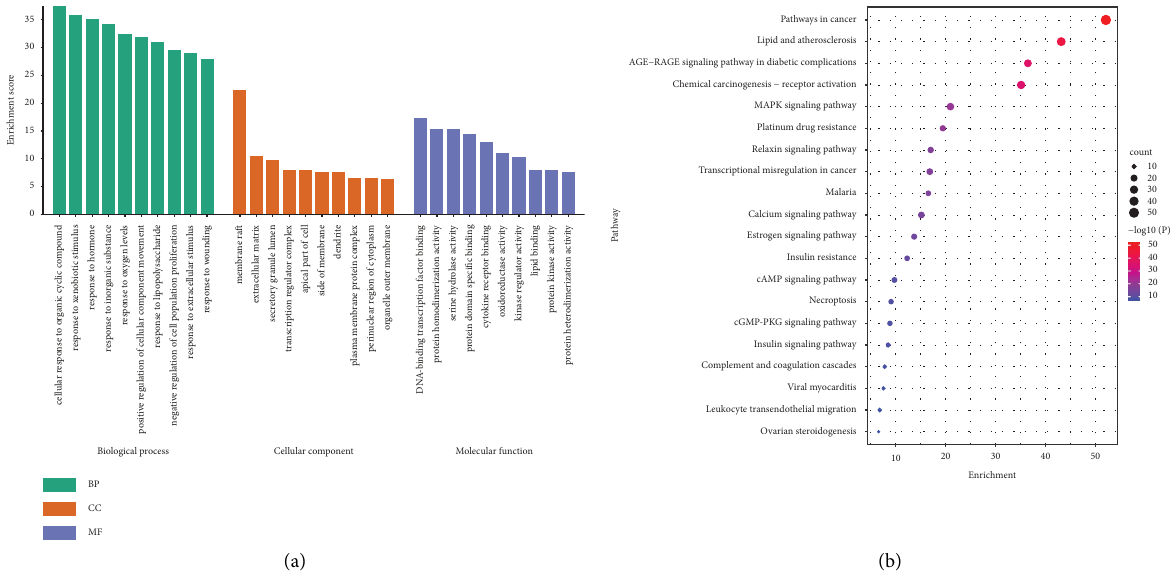
Figure 12: Enrichment analysis: (a) GO enrichment analysis. (b) KEGG enrichment